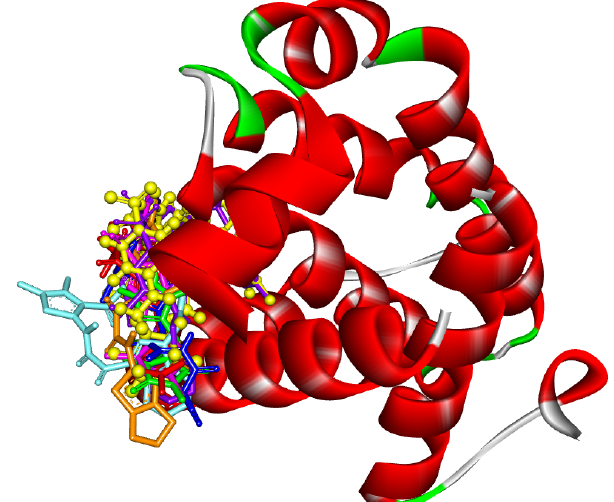
Figure 4. The 3D orientation of co-crystalline ligand of BCL2 (yellow, ball, and stick), the re-docked ligand (purple), compound 4b (blue sky); compound 4c (orang); compound 4e (red); compound 5a (dark blue); compound 5b (pink); compound 10 (green) inside the binding pocket of BCL2 (PDB: 6O0K).